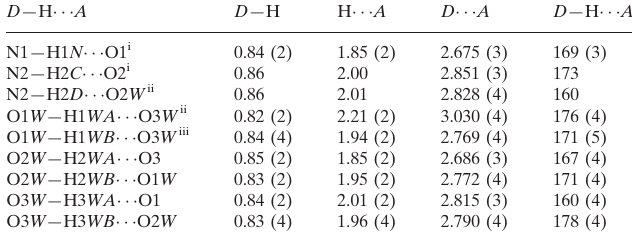
Hydrogen-bond geometry (A˚ , (cid:3)